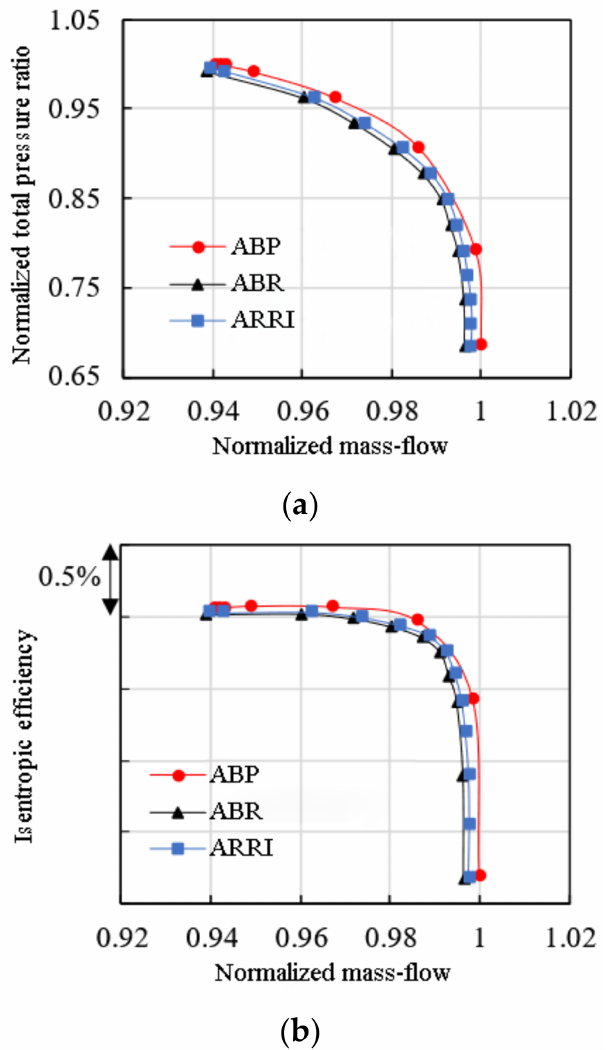
Figure 7. Comparison of compressor performance curves at design rotational speed under different roughness conditions. ( a ) Total pressure ratio versus mass flow, ( b ) Isentropic efficiency versus mass